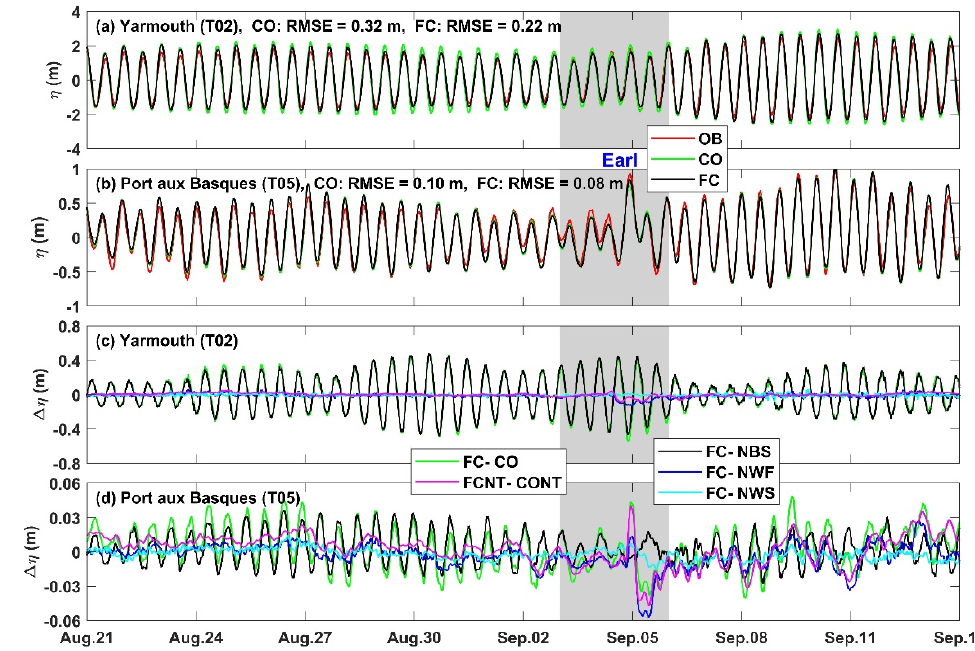
Figure 9. Comparison of the observed surface elevations (OB) and simulated values in runs CO and FC at ( a , b ) two tide gauges. Values of the RMSE for runs CO and FC are also shown. Changes in η between different model runs (see Table 1) at ( c , d ) are shown at these two tide gauges. To explore how the surface elevations are affected by the WCIs, we use differences in (cid:2015) between run FC and runs CO, NBS, NWF, and NWS to represent the effects of total wave-related processes, wave-enhanced bottom stress, wave-induced forces, and wave- dependent wind stress, respectively (Figure 9c,d). At Yarmouth (Figure 9c), the wave-en- hanced bottom stress (black) dominates the total variations of (cid:2015) due to WCIs (green) and the wave-induced forces (blue) cause the set-down of (cid:2015) during the storm. Surface waves enhance the stress in the coupled wave–current bottom boundary layer, which reduces the tidal amplitudes and the volume flux into the GoM. At Port aux Basques (Figure 9d), the wave-enhanced bottom stress (black) remains the dominant process during calm weather conditions. During the storm, the wave-induced forces (blue) contribute mostly to the peak storm surge and the following set-down, followed by the wave-dependent wind stress (cyan). The wave-enhanced bottom stress (black) adversely affects the wave- induced set-up and hinders the set-down following the peak surge. Differences between runs FCNT and CONT (magenta) represent the effects of all wave-related processes ex- cluding the tidal forcing. The magenta lines have much smaller values than the green lines, indicating that the variations of (cid:2015) are generally controlled by the wave–tide inter- actions at these two stations. The interactions between waves and storm surges become dominant at Port aux Basques during the storm. Furthermore, the magenta lines are close to the blue lines in Figure 9c,d, demonstrating the dominant role of wave-induced forces in the interactions between waves and the subtidal forcing.